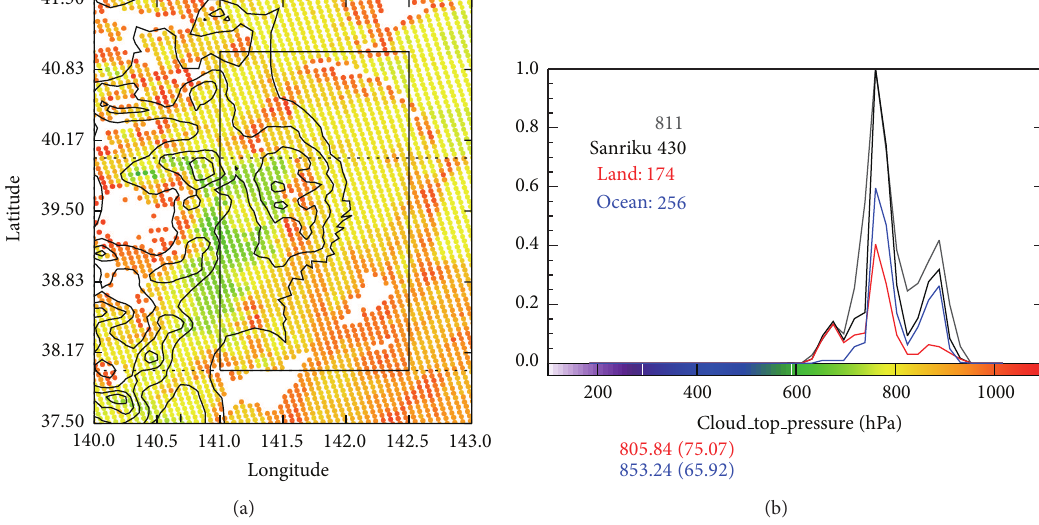
Figure 3: (a) Map of cloud top pressures [hPa] and (b) cloud top pressures normalized by the maximum value in the Sanriku region (black box in (a)) over the northern part of the main island of Japan, at approximately 0345 UTC July 22, 2003. The color shading indicates cloud top pressures according to the color bar in (b). The shading in (b) (grey, black, red, and blue) indicates maximum values over the entire swath, the Sanriku area, the land area, and the oceanic area in Sanriku, respectively. The values at the bottom of (b) show the averages and standard deviations (in brackets) for land (red) and ocean (blue) in the Sanriku